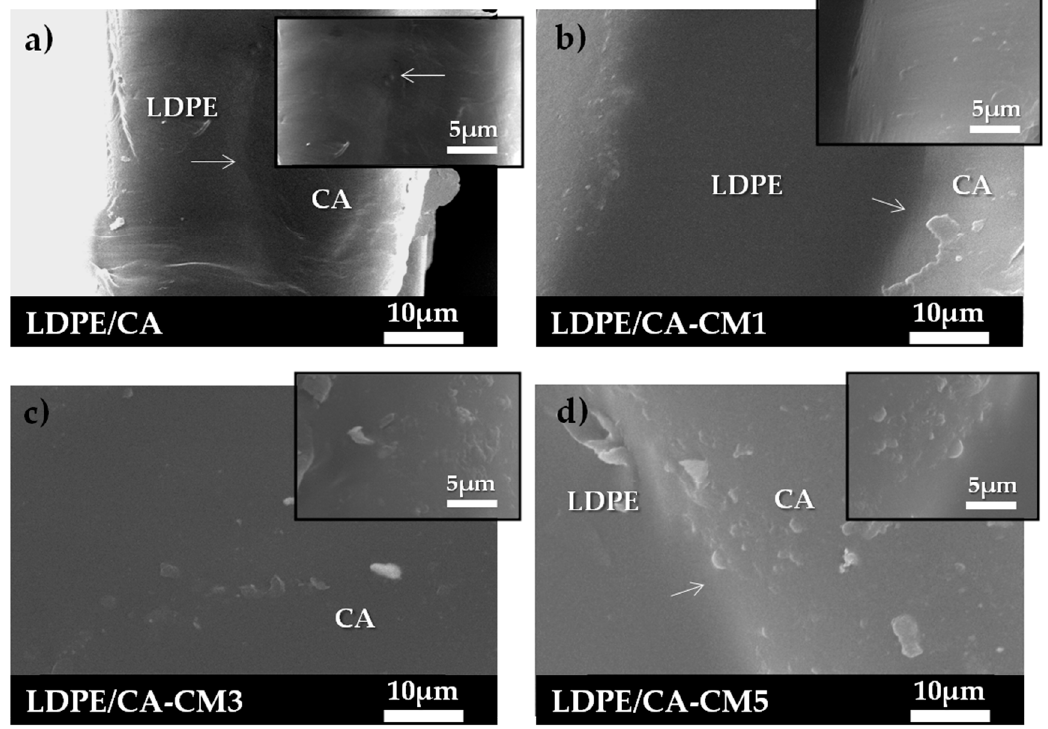
Figure 4. SEM of cross-fracture surface: ( a ) LDPE/CA, ( b ) LDPE/CA-CM1, ( c ) LDPE/CA-CM3, and ( d ) LDPE/CA-CM5. 2000× (inset figures 5000×).